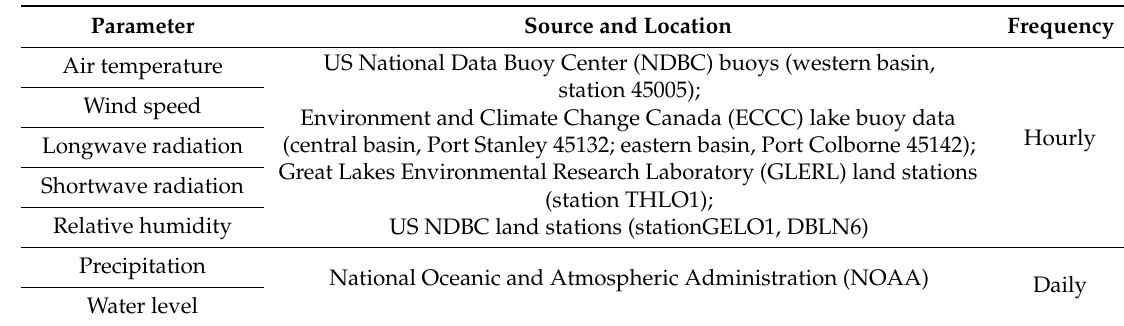
Table 1. Summary of sources of meteorological and water level data.